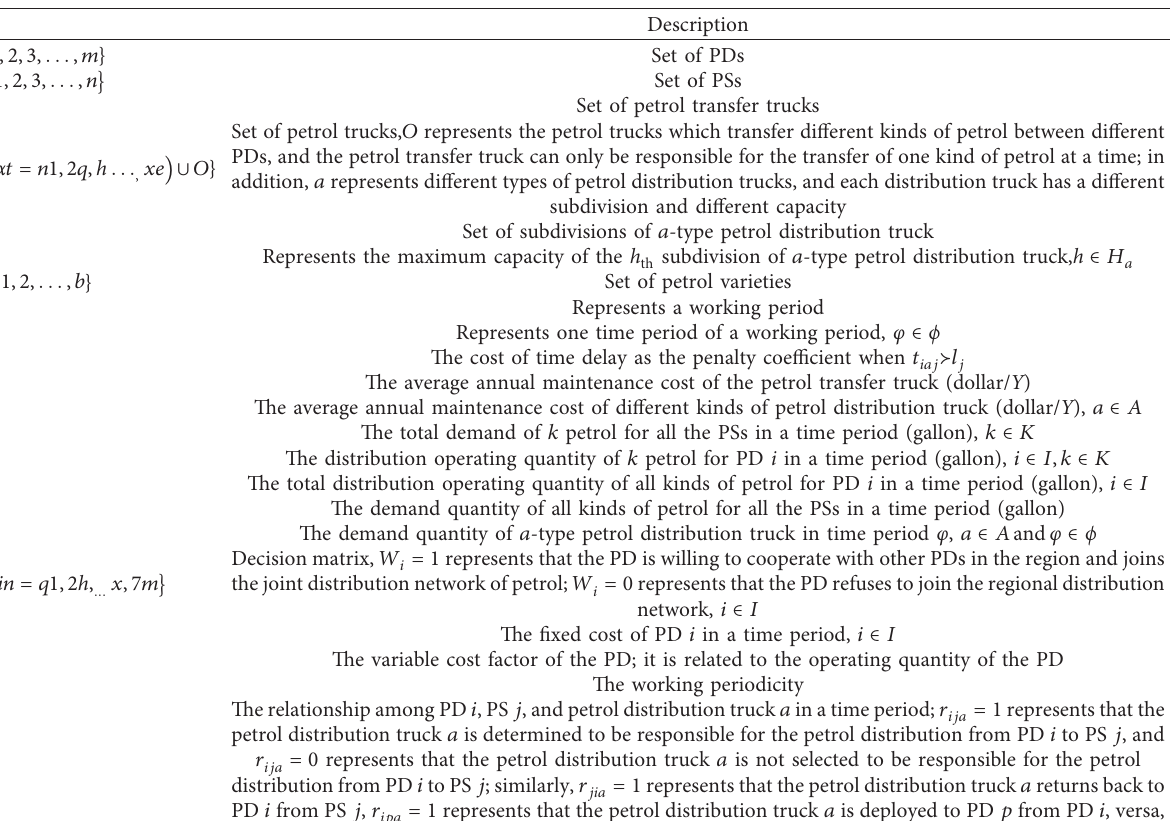
Table 2: Notations and definitions in the